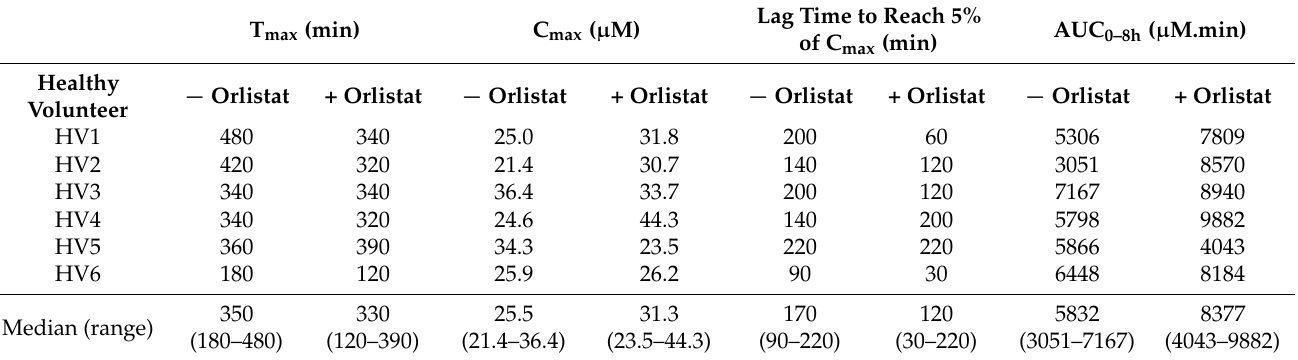
Figure 3. Individual concentration-time profiles of fenofibrate in the jejunum and fenofibric acid in the systemic circulation after intake of Fenogal (200 mg fenofibrate) in the fed state with ( • ) and without orlistat ( (cid:78) ). When digestion was inhibited with orlistat, a lipid layer was present upon centrifugation of multiple intestinal samples, hence concentrations in both total sample (lipid + micellar layer; • ) and micellar layer ( (cid:4) ) were determined in the fed state with orlistat. Table 1. Pharmacokinetic parameters of fenofibric acid in the systemic circulation after intake of Fenogal (200 mg of fenofibrate) in the fed state with and without